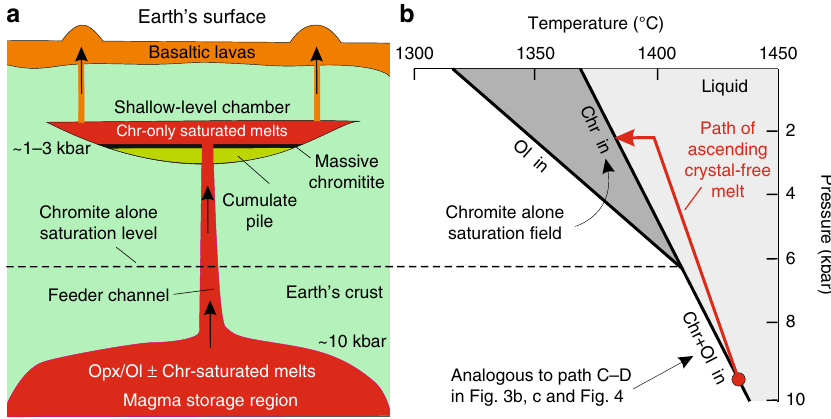
Fig. 5 A physical model for the generation of basaltic melts saturated in chromite alone by a reduction in lithostatic pressure. a Mantle-derived basaltic melts ascending from lower crustal storage regions, or a mantle source, inevitably experience a reduction in lithostatic pressure. This results in shifting of the chromite topological trough and, as a result, basaltic melts located alongside the chromite topological trough, at high pressure regions will become saturated in chromite alone during ascent to shallow-level chambers. Fractional crystallisation of a large volume of these chromite-saturated melts, in an open system where magma can also fl ow out of the chamber, will produce monomineralic layers of massive chromitites in ma fi c-ultrama fi c intrusions. b Phase relations for a primitive basalt (MgO = 15.13 wt.%; Cr 2 O 3 = 0.10 wt.%) in P – T space illustrating the model that basaltic melts located alongside the chromite topological trough fi rst become slightly superheated during their ascent and then saturated in chromite alone after stalling and cooling in shallow- level chambers. Therefore, allowing for the development of massive chromitites in shallow-level chambers. This case is analogous to path C – D in Fig. 3b, c and Fig. 4c, in which multiply-saturated liquids become saturated in chromite alone with pressure reduction. The phase diagram is simpli fi ed from Fig. 10 in ref. 28 and is only used to graphically illustrate the principle lying at the heart of our